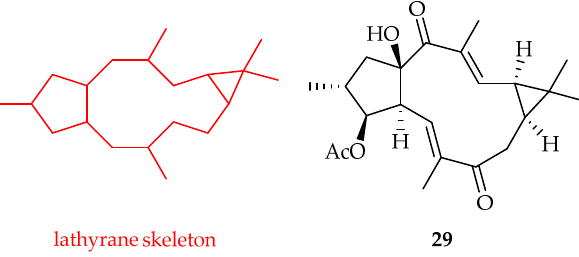
Figure 12. Structures of lathyrane skeleton and jatropodagin A 29 [22].